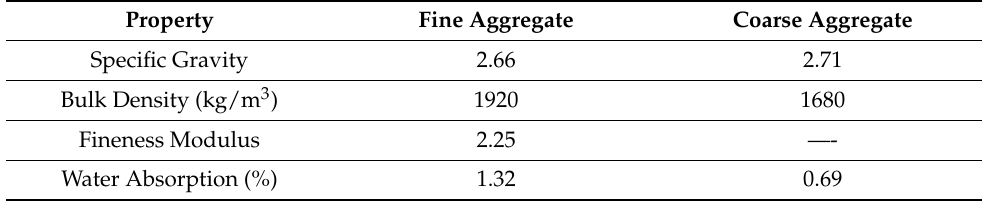
Table 2. Properties of fine and coarse aggregates. Property Fine Aggregate Specific Gravity